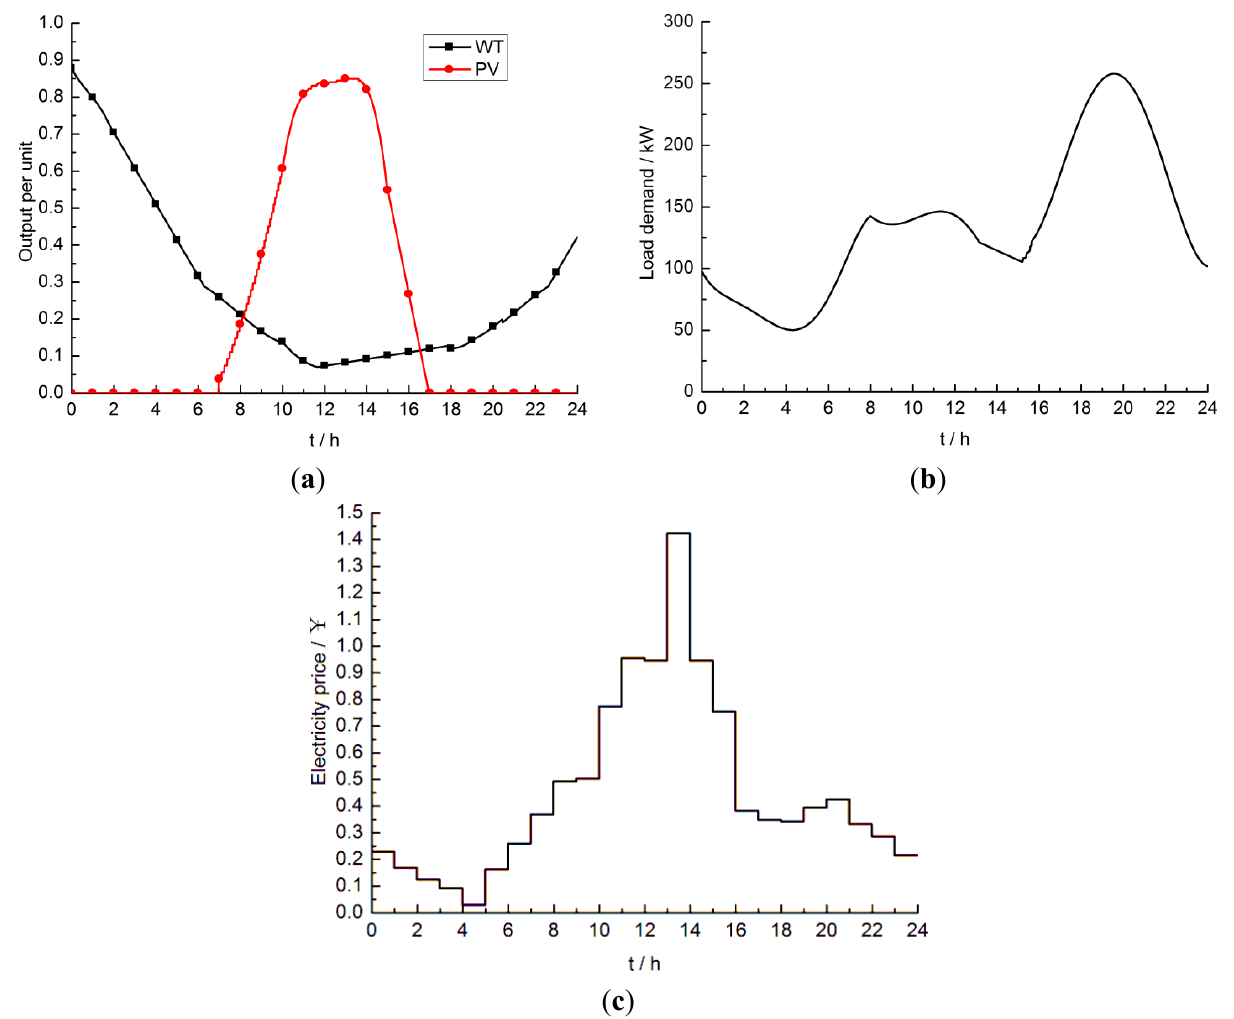
Figure 2. ( a ) Output per unit of WT and PV; ( b ) Load demand of microgrid system; ( c ) Electricity price of power